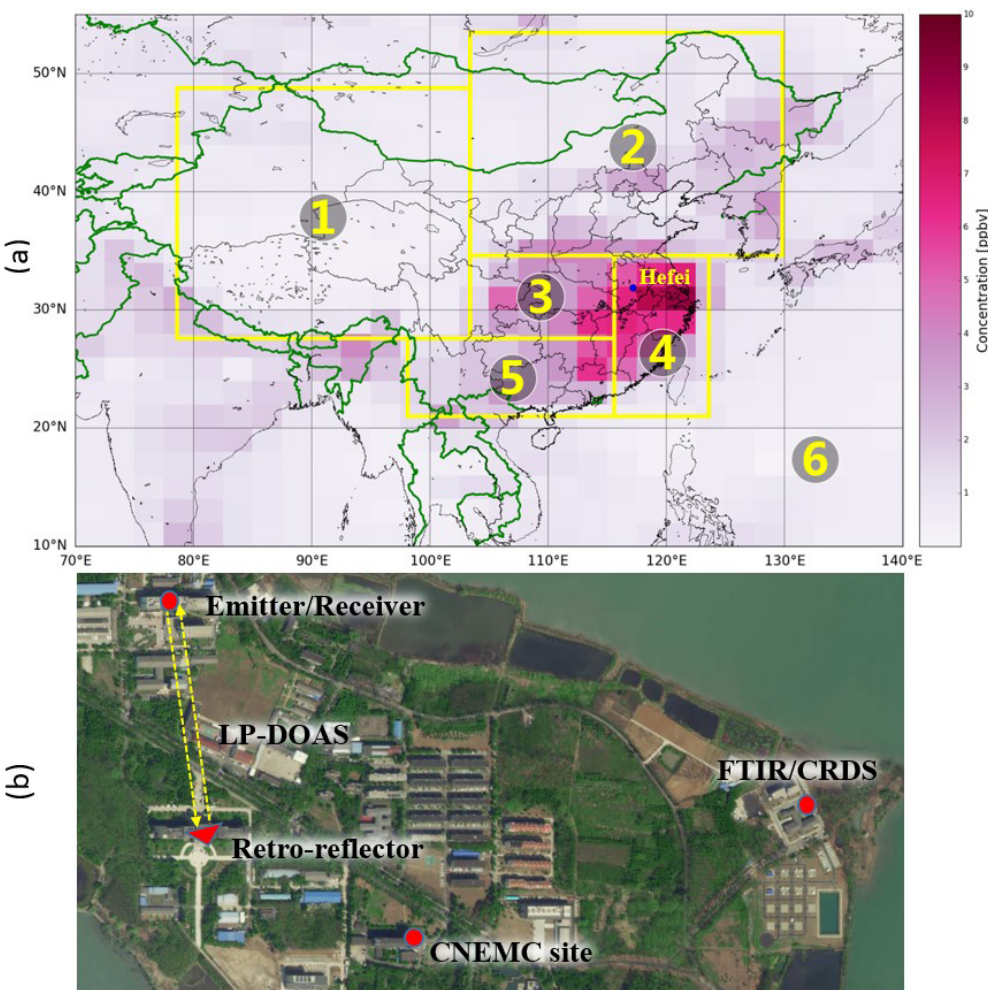
Figure 1. (a) Location of the FTIR site at Hefei, eastern China, and geographical regions used in GEOS-Chem sensitivity simulation. See Table 3 for latitude and longitude delimitation of each region. GEOS-Chem HCHO simulations on 24 July 2016 were selected for demonstration of summertime enhancement over eastern China. Region (1) covers a few sparse city clusters representing the region with the least population and industrialization in China. Regions (2), (4), and (5) cover the North China Plain (NCP), Yangtze River delta (YRD), and Pearl River delta (PRD) city clusters, respectively, which are the three most developed city clusters with severe air pollution in China. Region (3) covers the Sichuan Basin (SCB) and central Yangtze River (CYR) city clusters with newly emerging severe air pollution in China. (b) An overview of the location of the FTIR site, the CNEMC site and the optical path of the xenon LP-DOAS instrument. The base map of (a) is created by the Basemap package of Python. The base map of (b) is provided by AMAP software (http://ditu.amap.com/, last access: 24 January